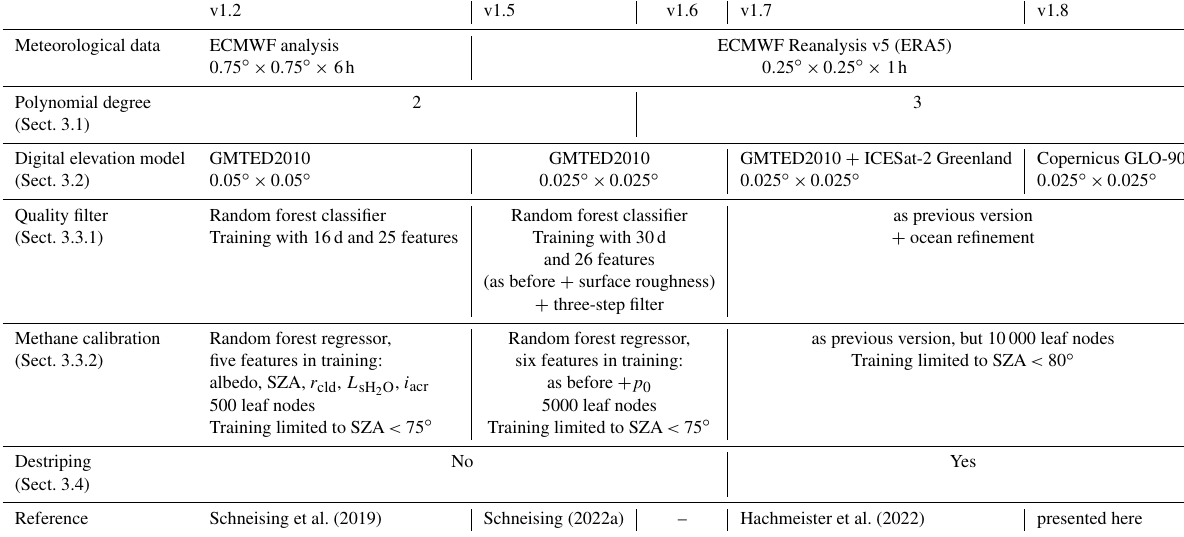
Table 1. Overview of the different TROPOMI/WFMD versions and the respective differences in the setup. For details see the main text. v1.2